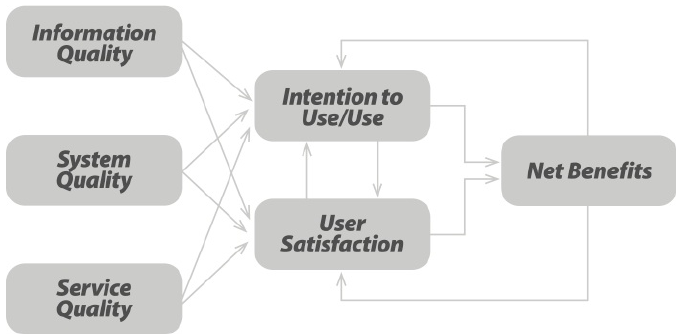
Figure 1 . DeLone and McLean’s updated information system